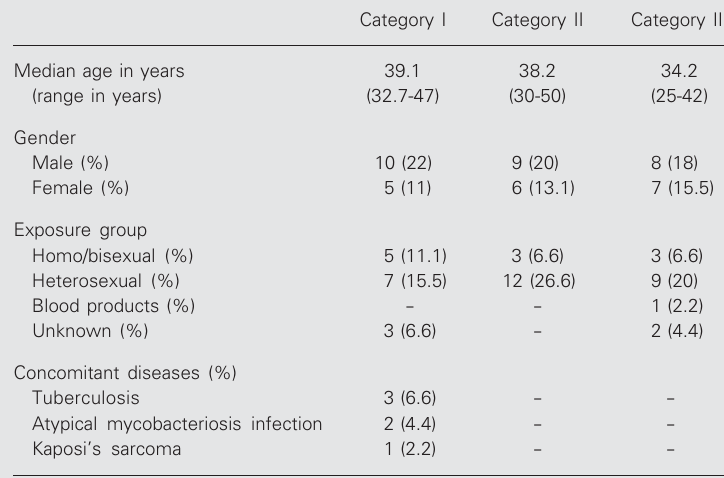
Table 1. Clinical data of the HIV+ individuals enrolled in the present